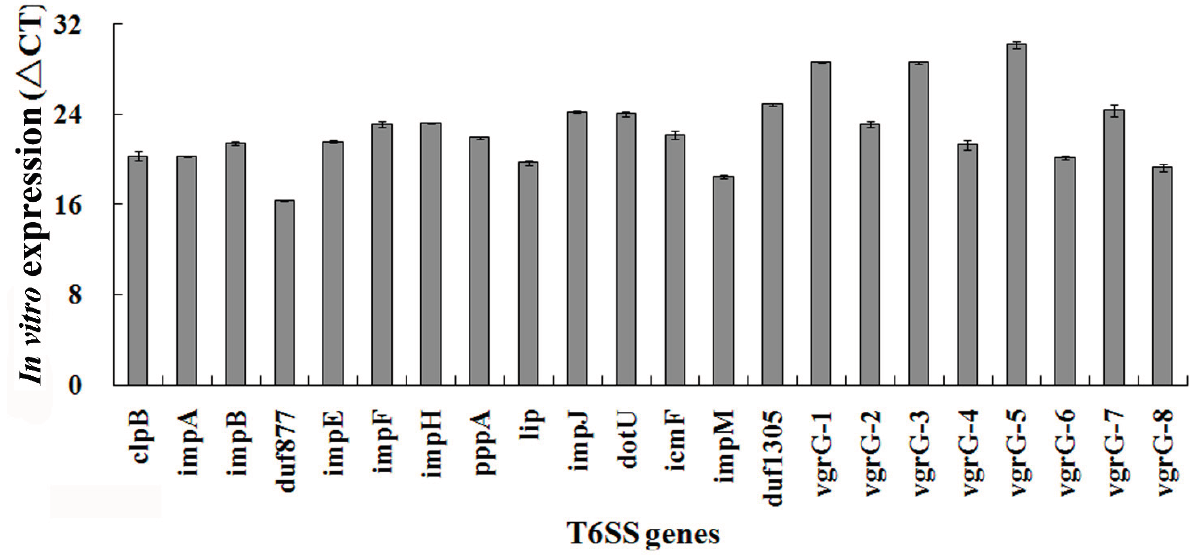
Figure 3. T6SS gene expression compared to 16S RNA gene, using quantitative real-time PCR in Acidovorax avenae subsp. avenae RS-1 under in vitro